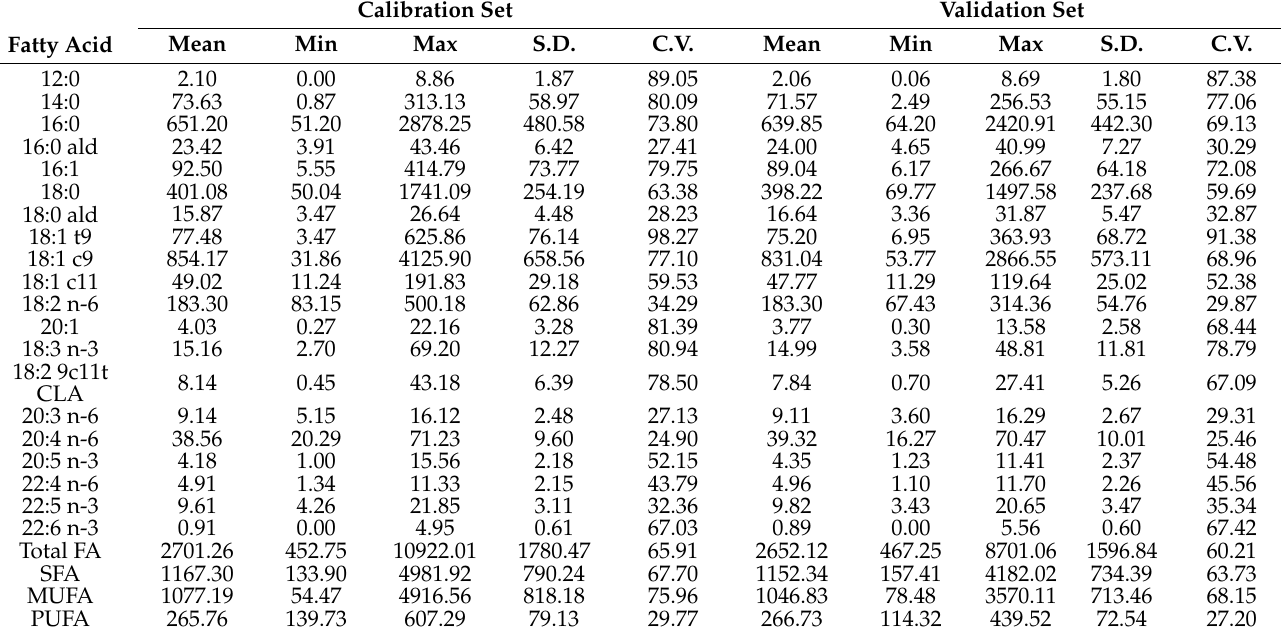
Table 2. Descriptive statistics of the total fatty acid composition (mg/100 g of meat) of calibration and validation sets. Calibration Set Validation